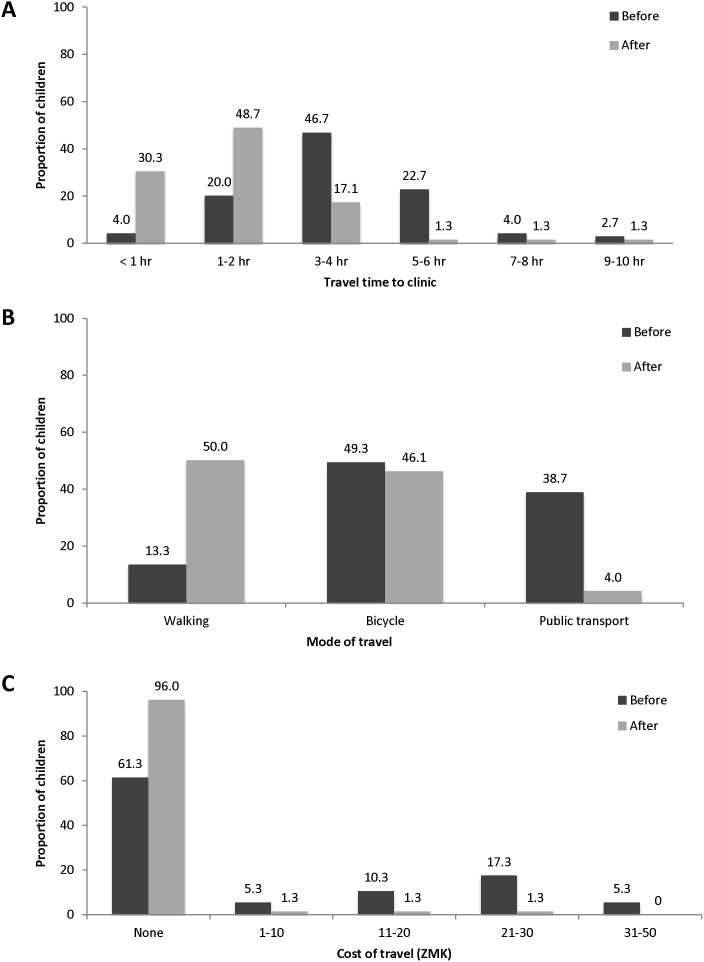
Travel time (A), mode (B), and cost (C) before and after transfer to outreach clinics.Note: participants were able to report more than one mode of travel to the clinic.